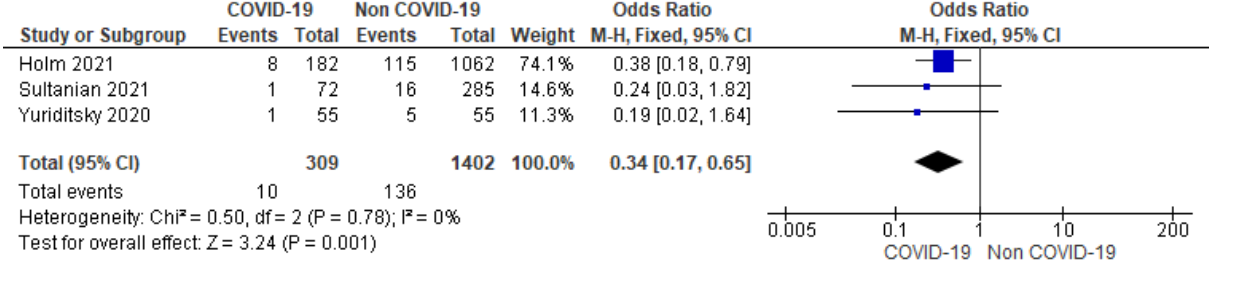
Figure 5. Forest plot showing group di ff erences on coronary angiogram among COVID-19 versus non-COVID-19 patients using fi xed e ff ect model. [13–15].